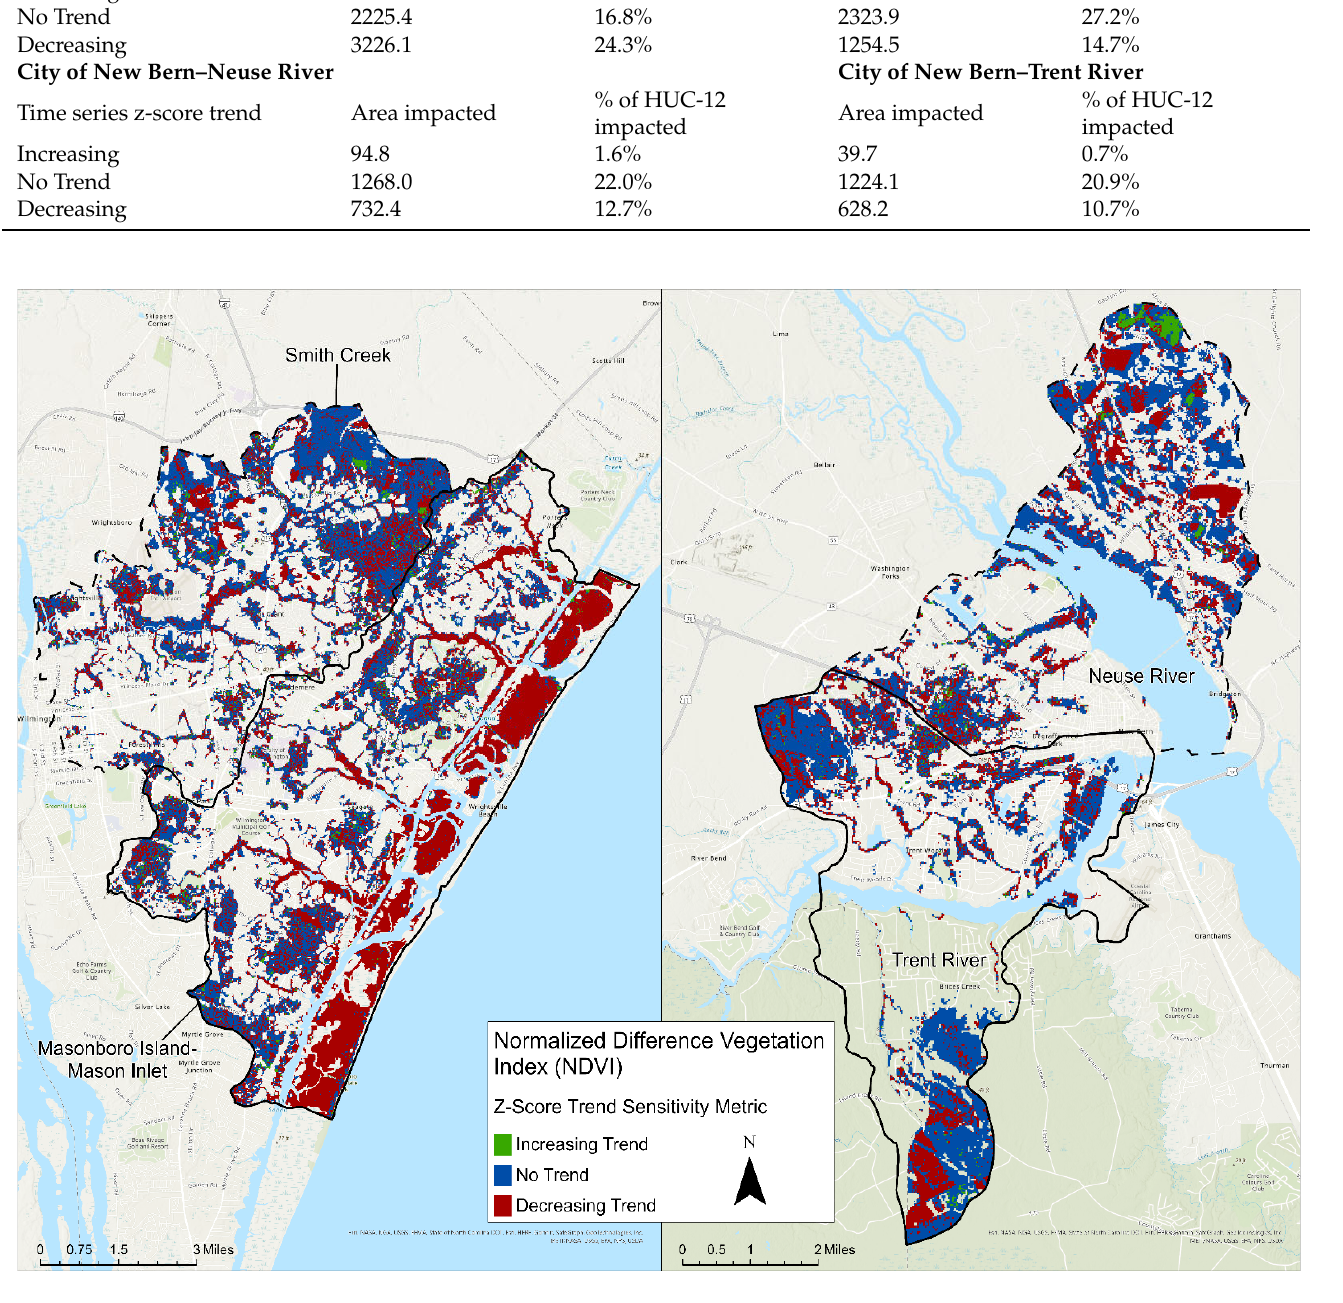
Figure 4. NDVI time series wetland sensitivity results for the Masonboro Island–Mason Inlet and Smith Creek subwatersheds in New Hanover County, NC. Smith Creek subwatersheds in New Hanover County, Table 3. Summary of the NDVI ‐ based time series analysis z ‐ score results for our four study areas in acres and as a percentage of the HUC ‐ 12 impacted.